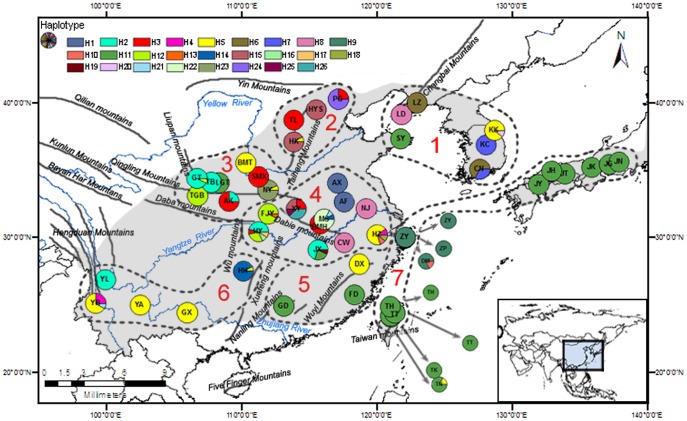
Distribution of 50 Q. variabilis populations (codes in Table 1) and 26 cpDNA haplotypes.The insert in the right bottom corner shows an overview of study area. The light gray shadow area is the current natural distribution of Q. variabilis
[29], [73].